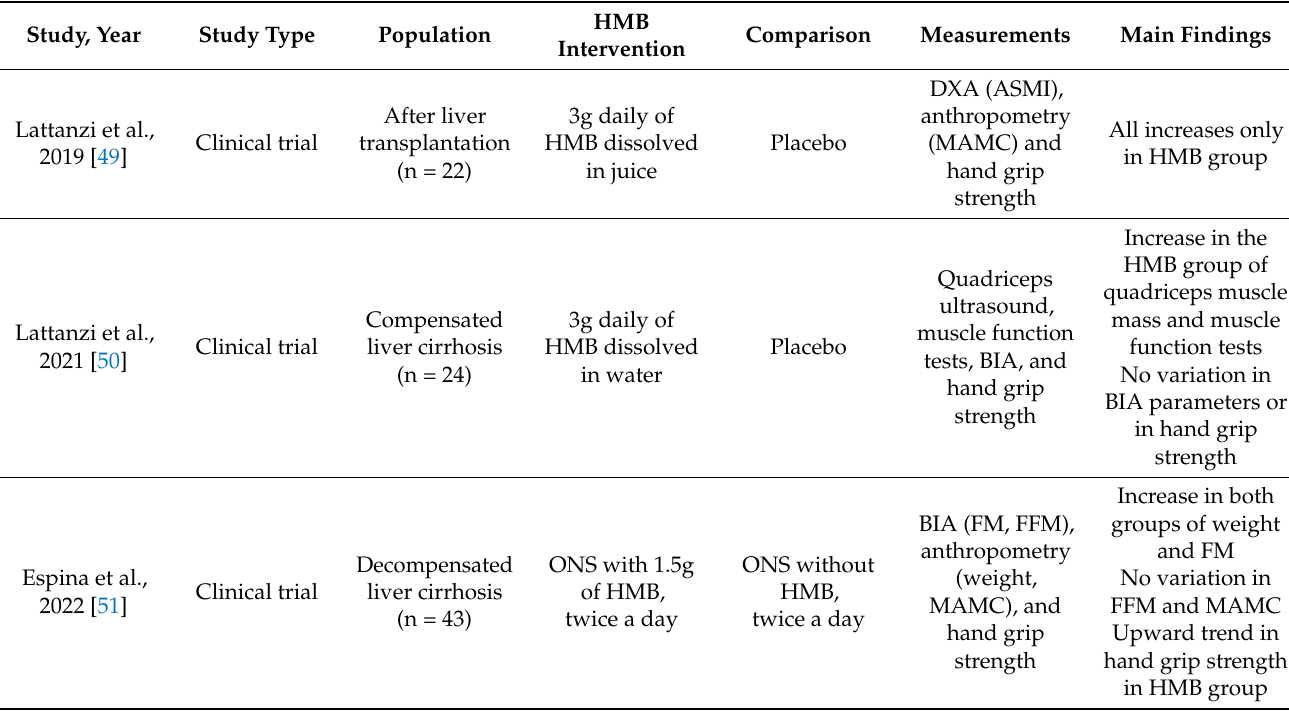
Table 4. Characteristics of the main clinical trials on HMB supplementation in